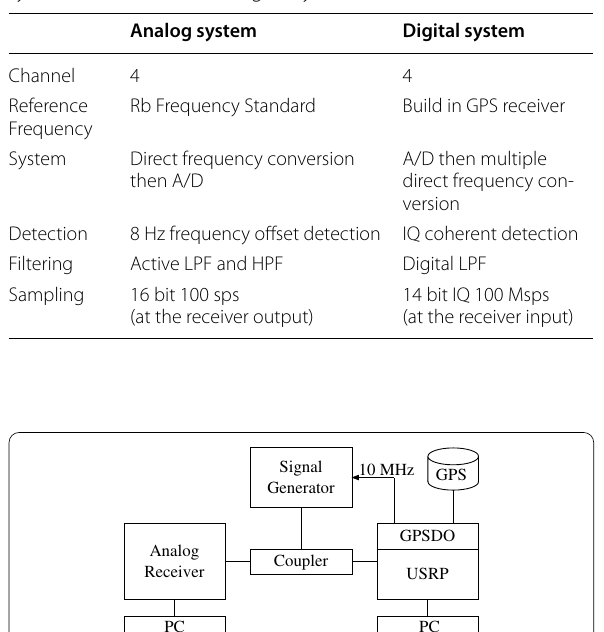
Table 3 The comparison of the specifications of the analog system with those of the digital system